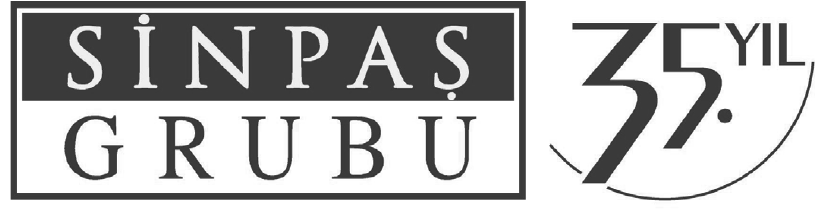
Fig. 2. Sinpa (cid:252) Group 35th Anniversary Emblem and Logotype.